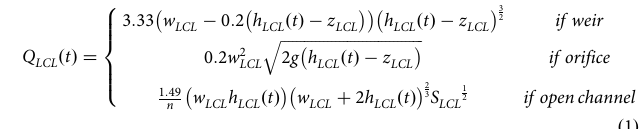
charts for each transit line (internal MBTA documentation), selecting junction locations as the boundaries of underground stations and at changes in track slope (i.e., points of vertical intersection, PVI, along the vertical track alignment). Links are further described by a length, Λ L ¼ f λ L k j k ¼ 1 ; 2 ; ¼ ; L g also obtained directly from track alignment charts, and a tunnel cross-section as provided the MBTA tunnel inspection manual (internal documentation). We consider each rapid transit line tunnel as a separate series of connected links. Hydraulic interconnections at connecting (i.e., transfer) stations are modeled via inclusion of a separate link, whose length and cross section are informed by the total number of inter- connections (i.e., staircases, elevator shafts, multi-level mechanical rooms) between connecting transit lines at the station as identi fi ed in as-built construction drawings (internal MBTA documentation). In addition to the main interconnected under- ground portions of the system in Downtown Boston, we model the Red Line tunnels in Cambridge and Dorchester as independent tunnel sections in the ana-